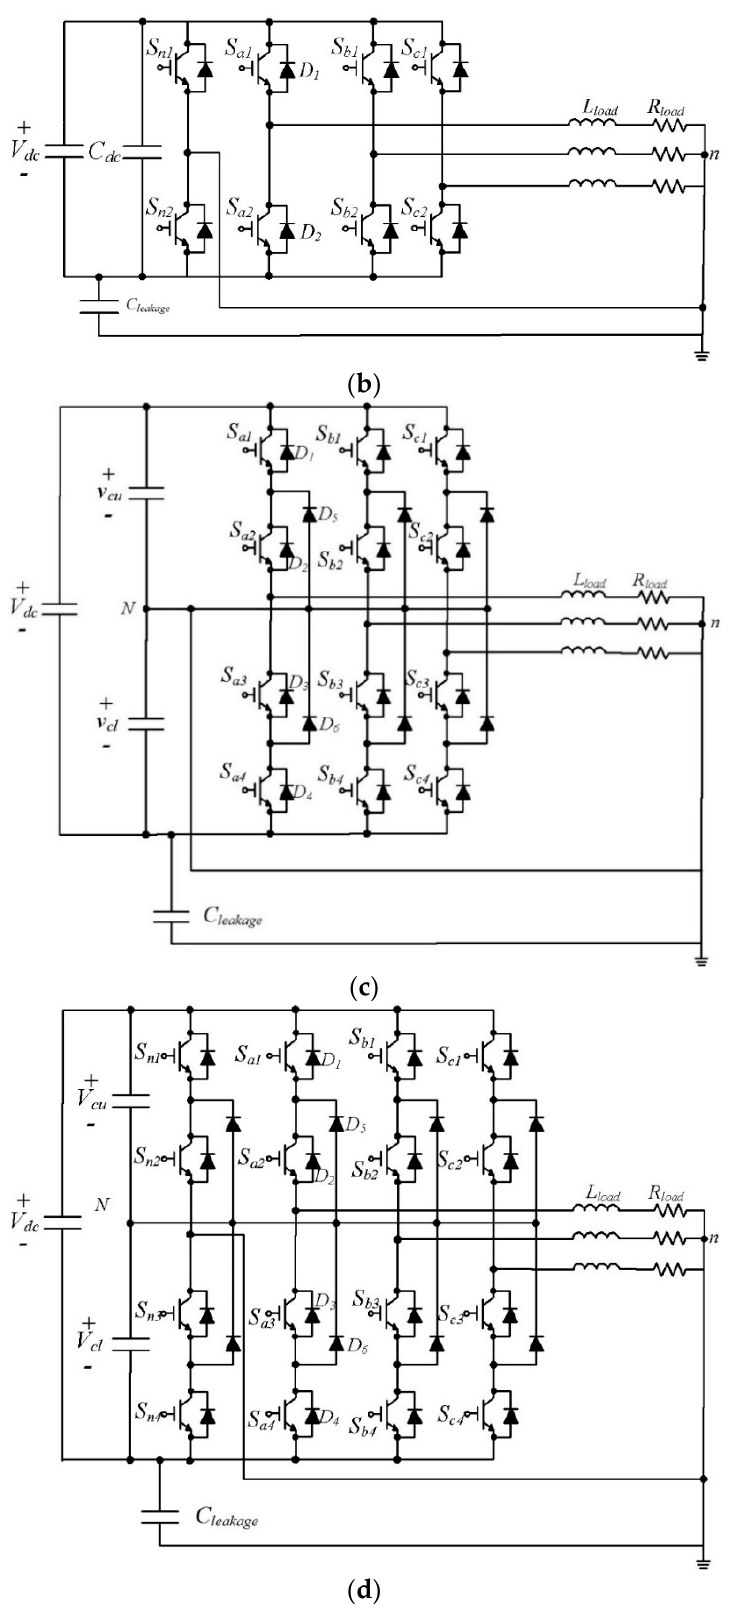
Figure 1. Three-phase four-wire DC/AC inverter block diagram; ( a ) two-level/three-leg topology; ( b ) two-level/four-leg topology; ( c ) three-level/three-leg topology; ( d ) three-level/four-leg topology.